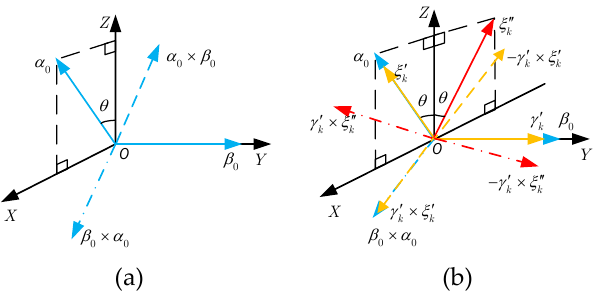
Figure 3. Placement of projection vectors. ( a ) Placement of α 0 and β 0 . ( b ) Placement of four cases of the estimated projection vectors.